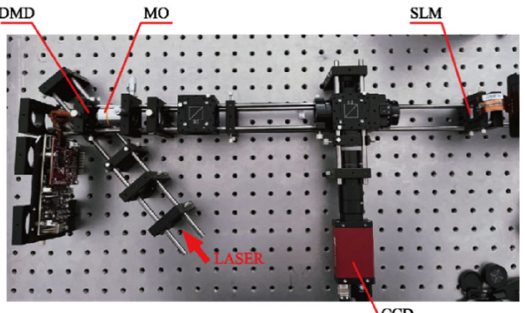
Figure 6. Optical configuration.